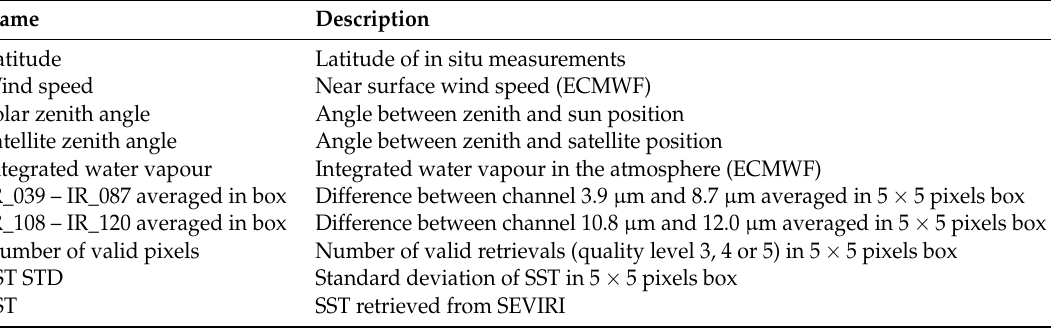
Table 1. Description of the Match-up DataSet (MDS) ancillary